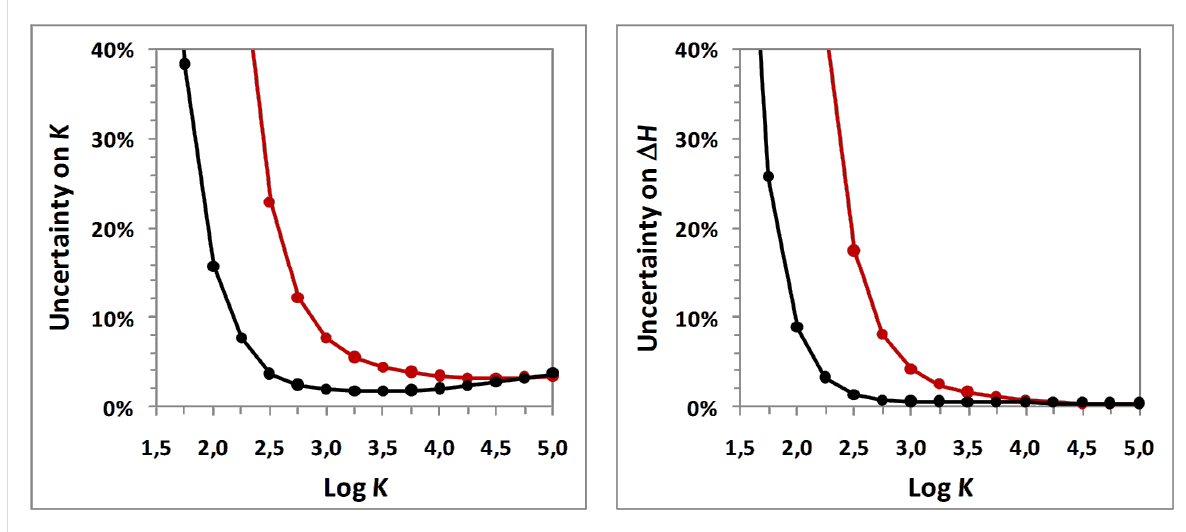
Figure 3: Theoretical uncertainty on K (left) and Δ H (right) as a function of Log K for titration-titration (red curve) and titration-release (black curve) approaches given an aqueous guest solubility equal to 2 mM and for an inclusion enthalpy equal to − 3000 cal·mol − 1 .